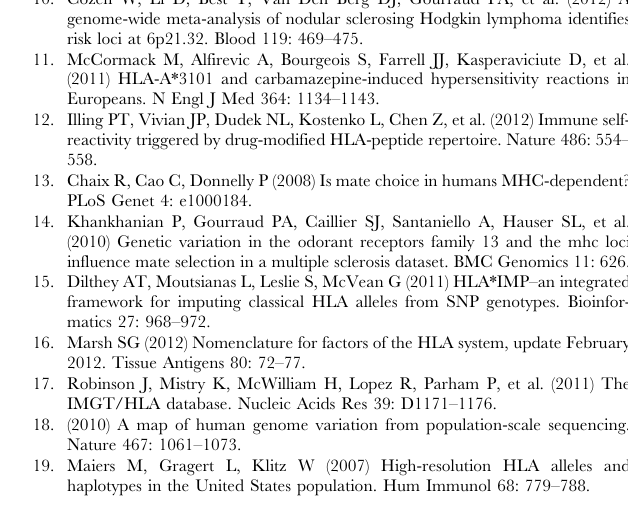
Figure S1 MHC region definition. A, Selection of the region by recombination rate et variants’ density. B, chr16:86,750,000– 91,650,000, a region on chromosome 16 with similar recombina- tion rate as MHC shown in Figure 1D. C , chr16:74,200,000– 79,100,000, a region on chromosome 16 with similar variants’ density as MHC shown in Figure 1C. (TIF) Figure S2 Screen capture of the display of allelic frequencies in dbMHC for the 1000 genome populations. A, Homepage. B, Population selection. C, Data download. (TIF) Figure S3 Correlation between sample size and the 90 th percentile of D 9 (S3-A) and r2 (S3B) in African American samples for markers’ pairs at a distance of 400 kb.